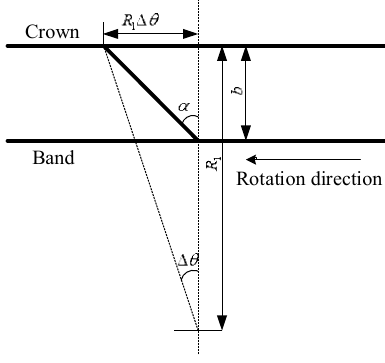
Figure 13. Blade stacking condition.